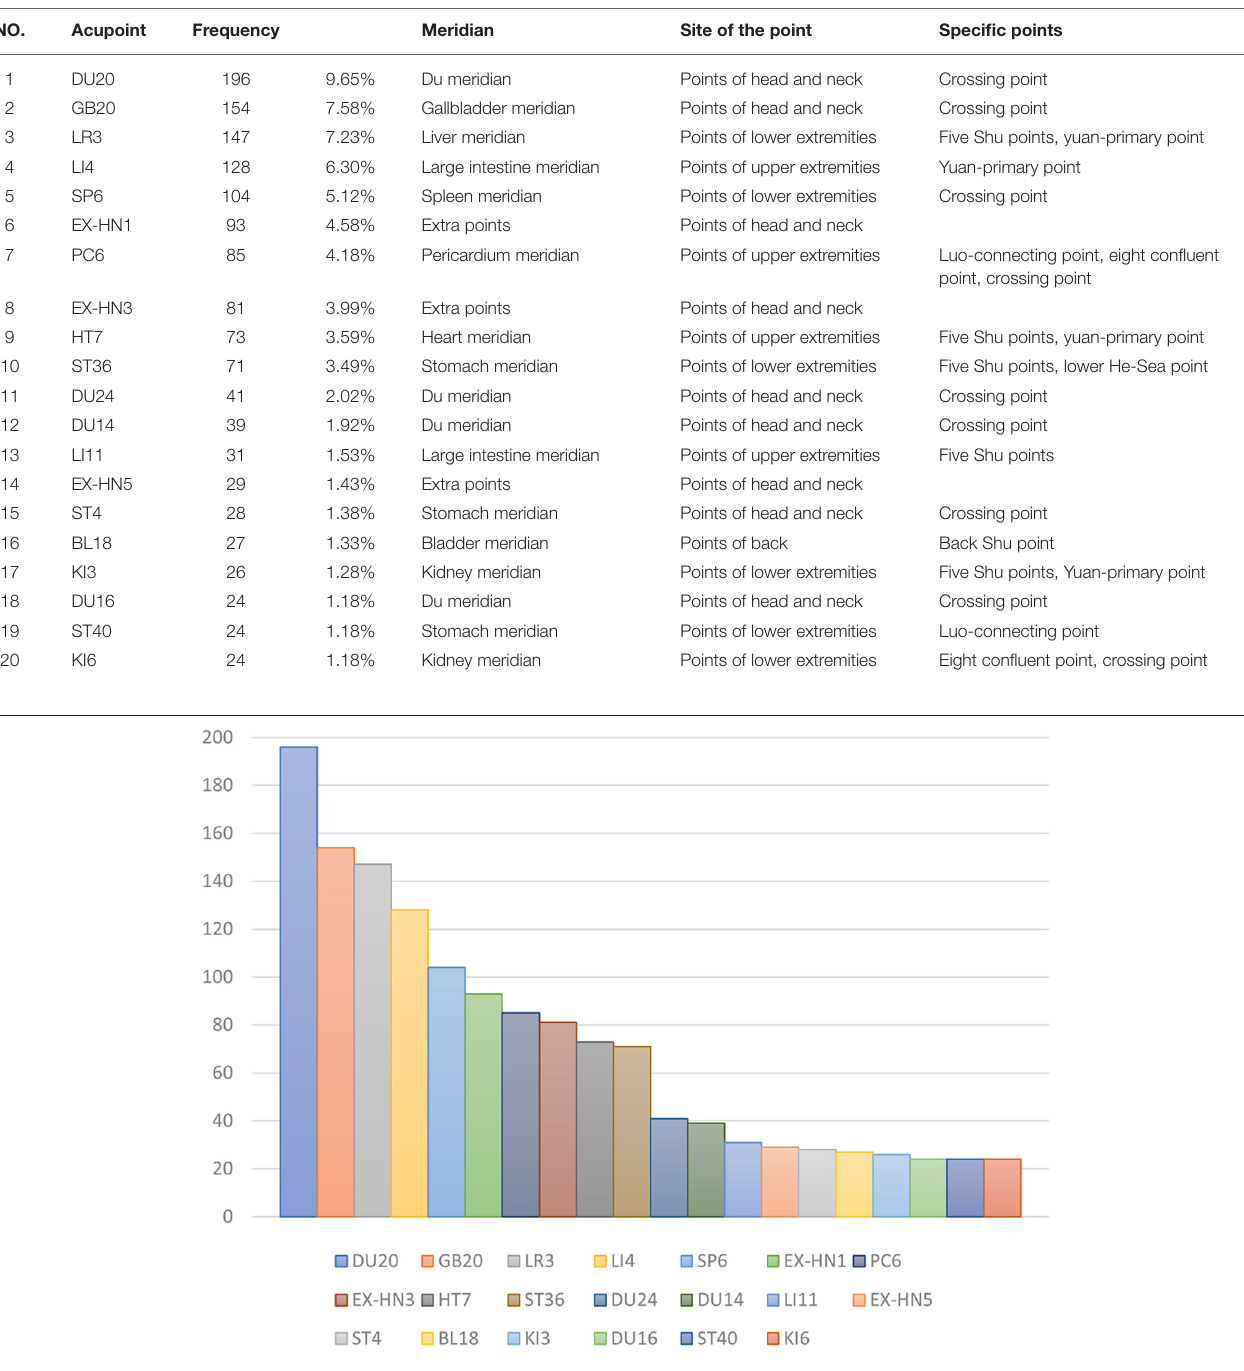
meridian with the most acupoints involved was the bladder meridian, comprising 18 acupoints, but this meridian had a low frequency of